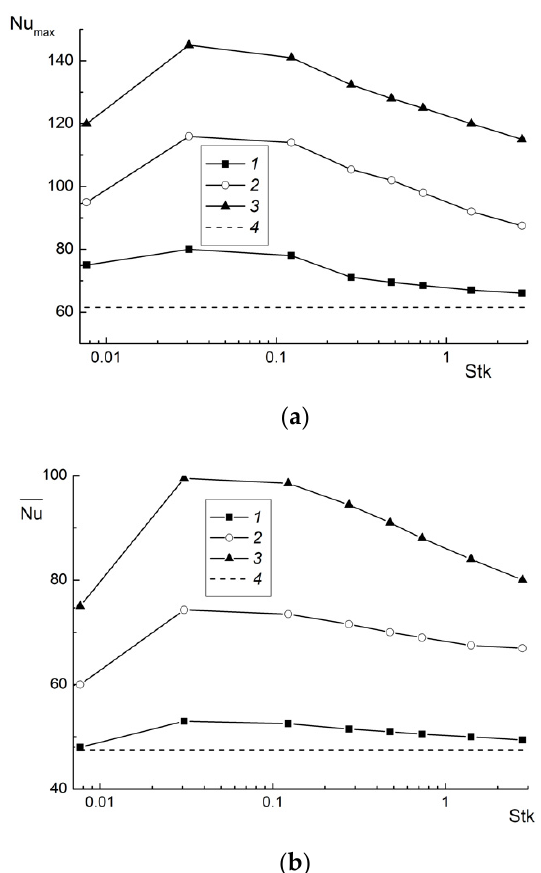
Figure 10. The effect of mean Stokes numbers (inlet droplets diameter) on ( a ) the maximal value of heat transfer and ( b ) averaged heat transfer. 1: M L 1 = 0.02; 2: 0.05; 3: 0.1; 4: single-phase flow.